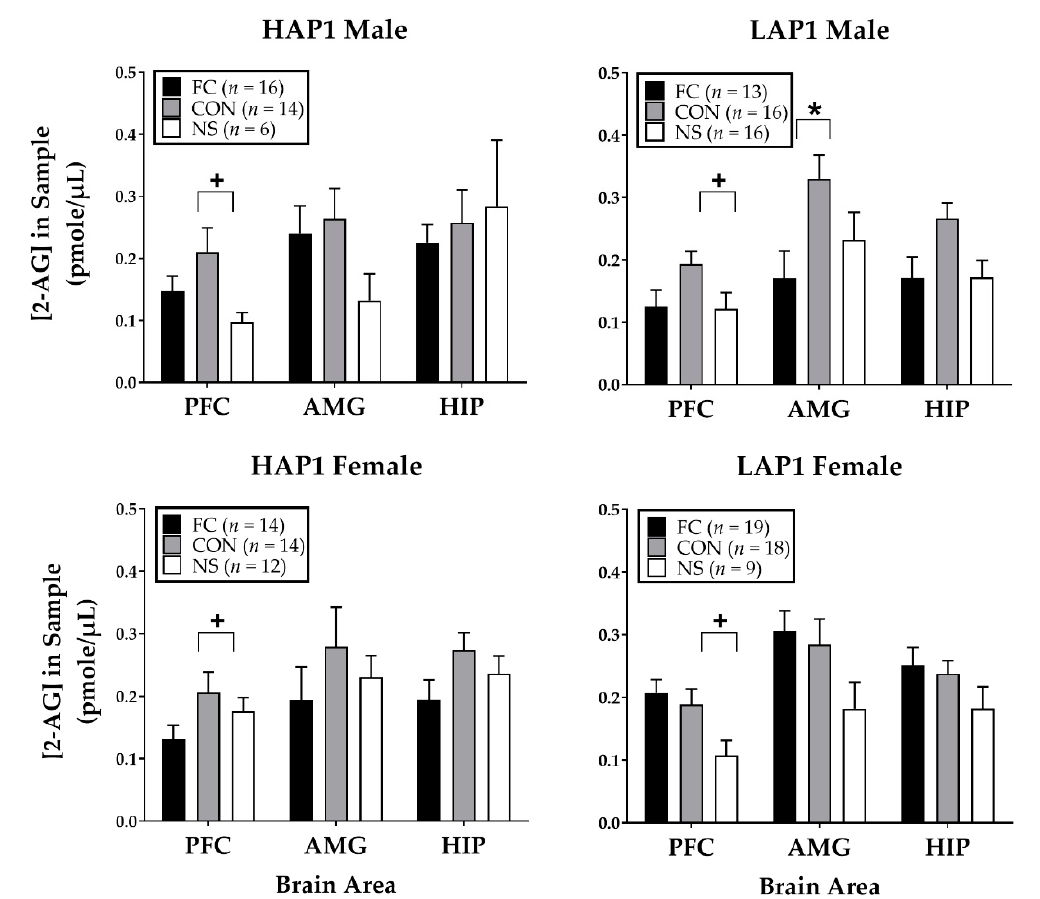
Figure 3. Mean ( ± SEM) 2-AG expression immediately following FPS testing in HAP1 (left panels) and Figure 3. Mean (±SEM) 2 ‐ AG expression immediately following FPS testing in HAP1 (left panels) and LAP1 (right panels) male and female mice in the fear-conditioned (FC; paired light + shock), control LAP1 (right panels) male and female mice in the fear ‐ conditioned (FC; paired light + shock), control (CON; unpaired light and shock) and no-shock (NS; light only) groups for experiment 1. + p < 0.01, (CON; unpaired light and shock) and no ‐ shock (NS; light only) groups for experiment 1. + p < 0.01, CON > NS (collapsed across line and sex); * p < 0.05, male LAP1 CON > FC. CON>NS (collapsed across line and sex); * p < 0.05, male LAP1 CON > FC. Correlations between % FPS within each treatment group and 2-AG levels in each brain area yielded no significant